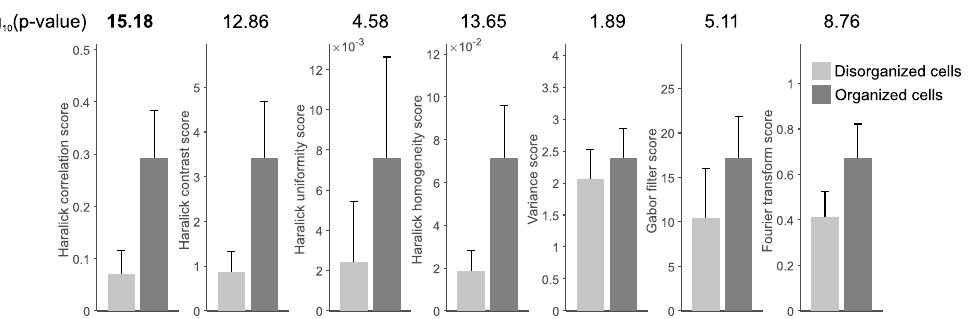
Figure 5. Comparison of sarcomere organization metrics in discriminating organized and disorganized cardiomyocytes. Selected highly organized (n = 32) and disorganized (n = 26) neonatal mouse cardiomyocytes were used to quantitatively compare methods for measuring sarcomere organization. Out of 13 Haralick pixel- based measurements, 4 were identified as candidates for sarcomere organization measurements. − log 10 (p-values) are reported above each pair. P-values are calculated by two-sample t-tests. Error bars show standard